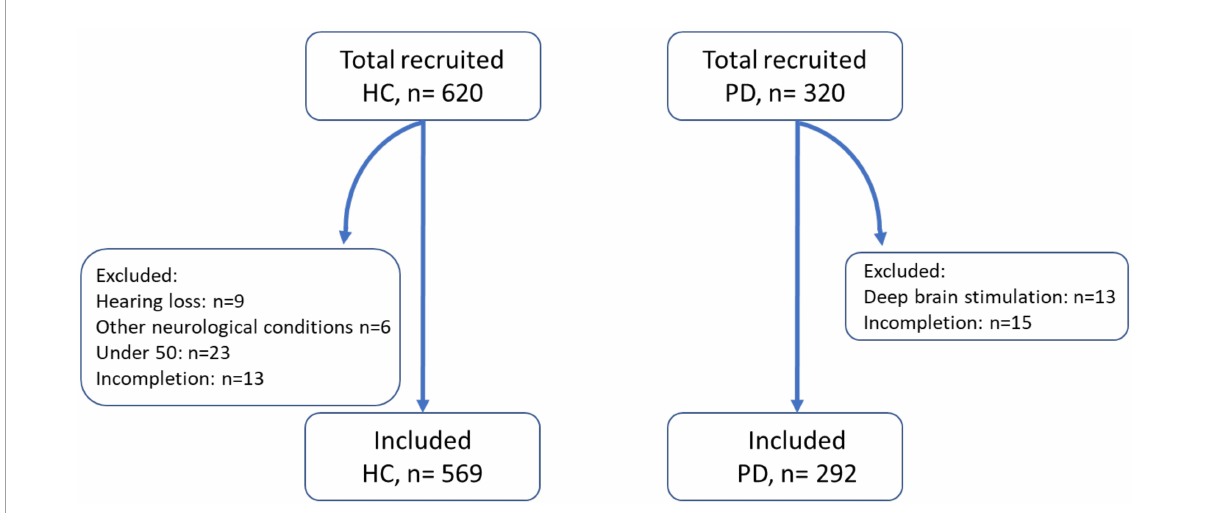
FIGURE2 Number of control and patient participants recruited, excluded, and included for analysis. HC, healthy control; PD, Parkinson’s disease patients. Other neurological conditions included multiple sclerosis and